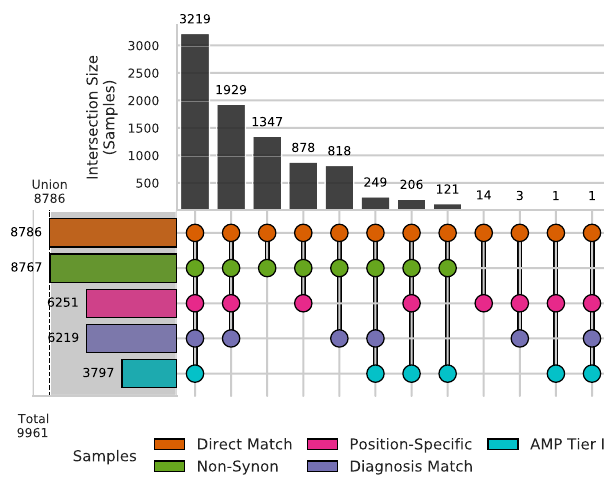
Fig. 7 Division of the therapeutic matches to the TCGA samples ( n = 9,961). The total set of matches is further subdivided by a number of fi lters. Samples were considered disease matched when the diagnosis of the patient matched the disease listed by the annotation (Diagnosis Match) Samples were considered position matched (Position-Speci fi c) when matches to non-speci fi c gene-level small mutations were excluded. Other fi lters included: matches with AMP Tier I compatible evidence (AMP Tier I); matches excluding those obtained by second-pass or inferred matching (Direct Match); and fi nally only non-synonymous, at the protein level, mutations (Non- Synon). The union of all matches is given by the shaded portion and vertical dashed line. Source data are provided as a Source Data fi le.